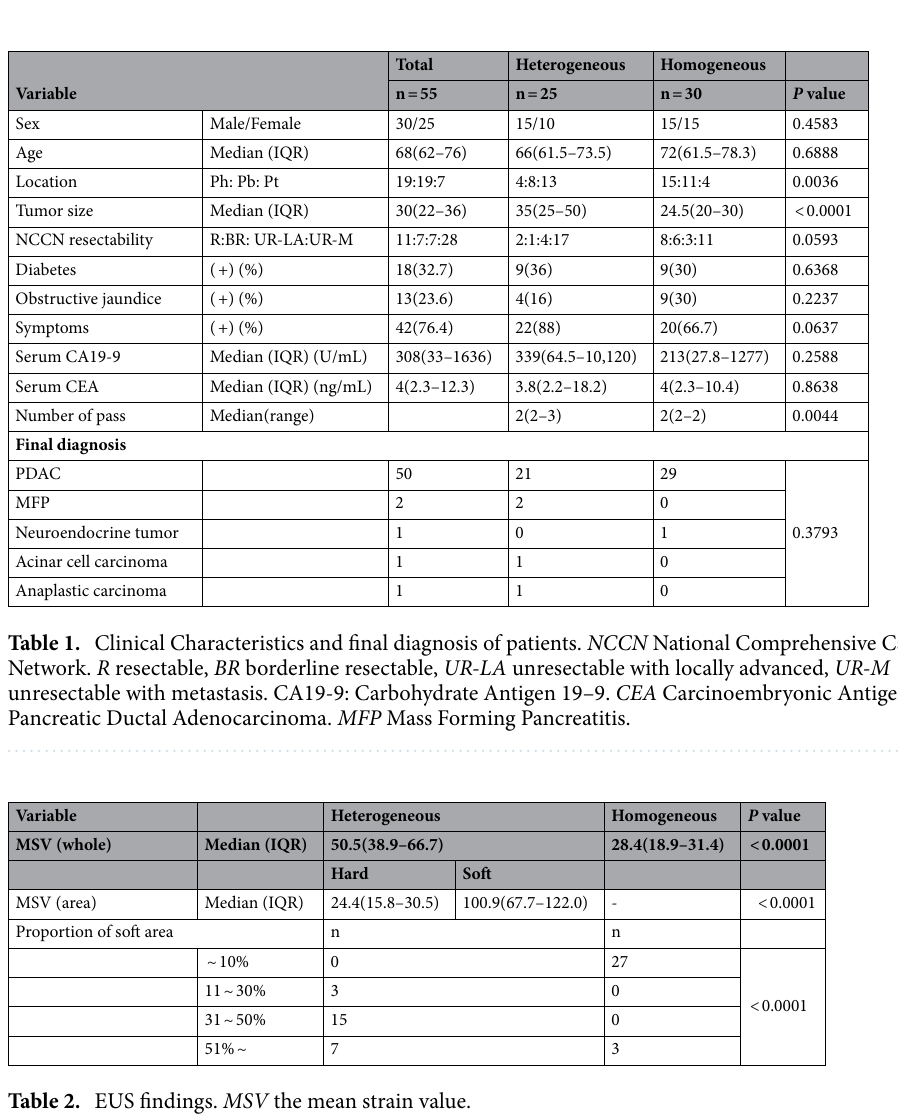
Table 2. EUS findings. MSV the mean strain